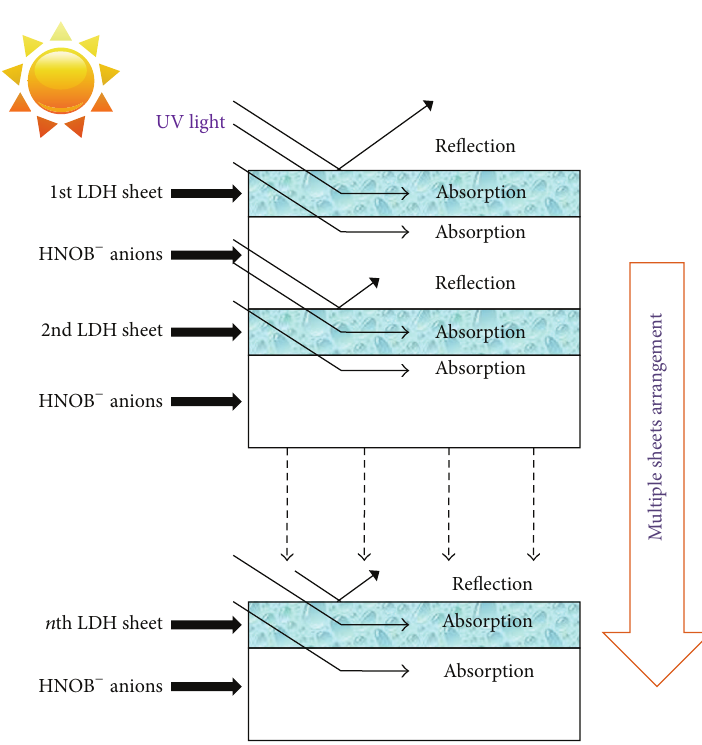
Figure 8: UV adsorption and reflection mechanism of Zn/Al-HNOB − -LDH.